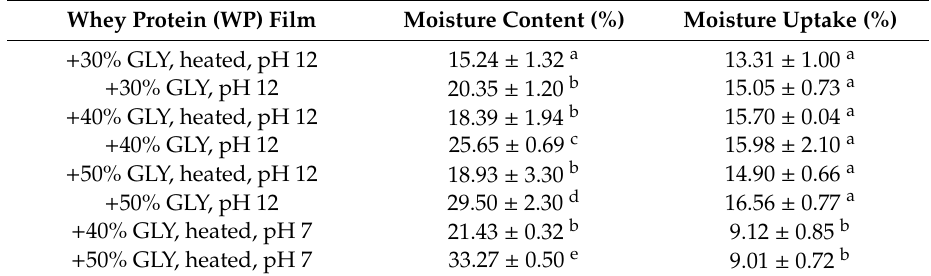
Table 7. Moisture content and uptake of whey-protein (WP)-based films obtained under di ff erent experimental